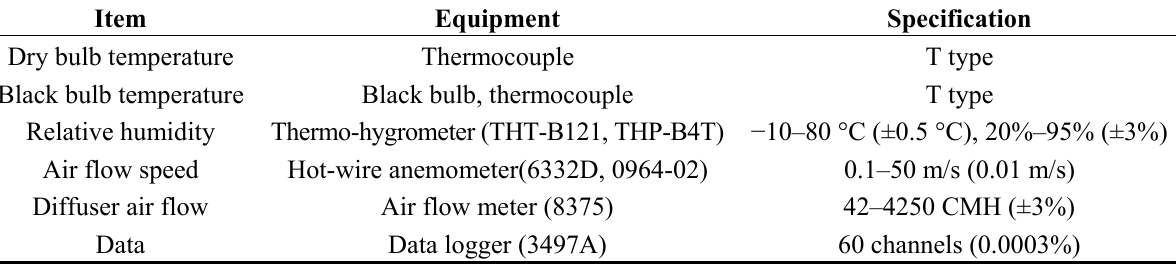
Table 3. Itemized equipment and specifications.